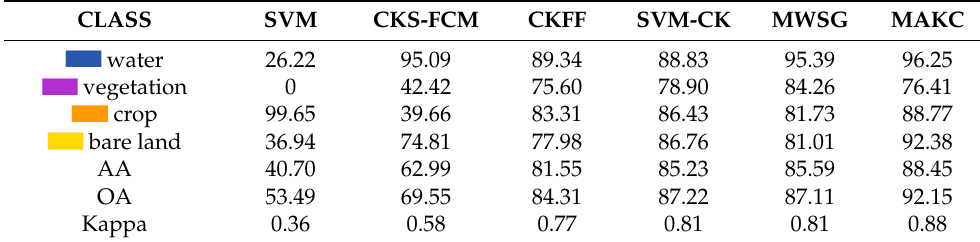
Table 5. Classification precision results on